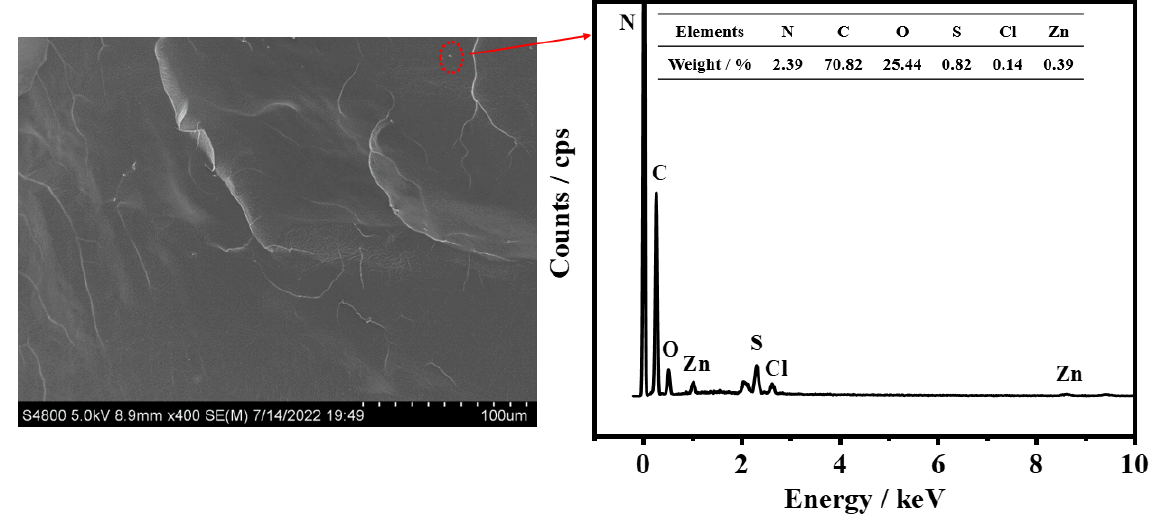
Figure 7. EDS profile of the MPU/AO ‐ 80 composite with 32 phr of AO ‐ 80 (3MCPG ‐ 32).